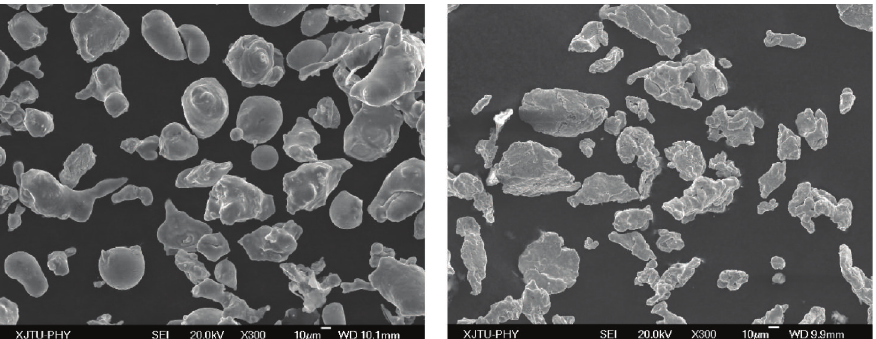
Figure 10: SEM micrograph of iron powders.